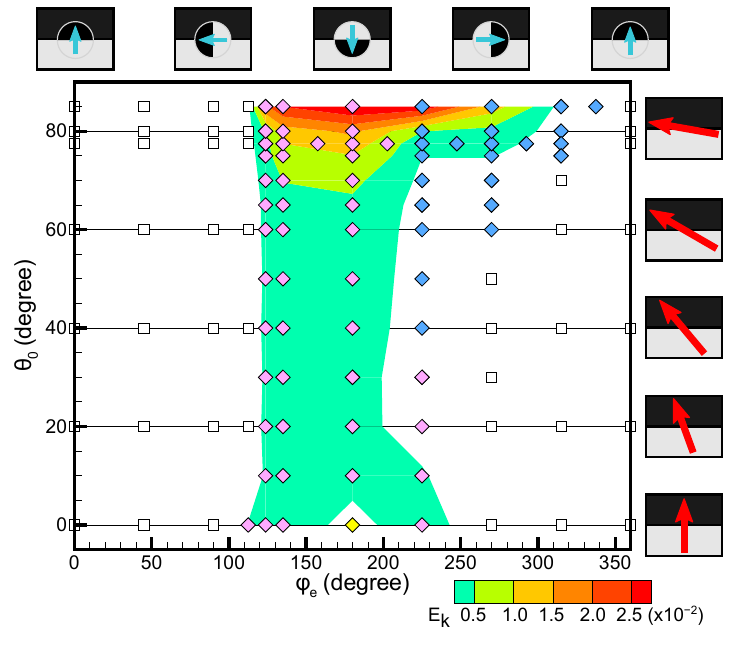
Figure 58: Diagram showing the parameter study of Kusano et al. (2012) with various shear angles 𝜃 0 and the emerging flux orientation 𝜑 𝑒 . The orientations of the coronal and emerging fields for different 𝜃 0 and 𝜑 𝑒 are also shown. Image reproduced with permission, copyright by